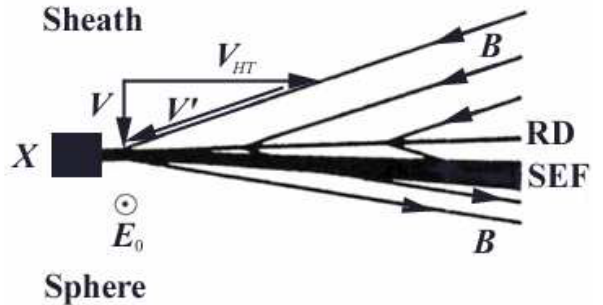
Fig. 1. Schematic drawing illustrating the difference between the deHoffmann-Teller (HT) frame and the proper frame (the frame of the drawing) for an asymmetric two-dimensional reconnection con- figuration at the magnetopause. This configuration (only half of which is shown) contains an upstream rotational discontinuity (RD) followed by a slow-mode expansion fan (SEF) (Levy et al., 1964). In the HT frame, which moves to the right with speed V HT rela- tive to the proper frame, the plasma flow, V 0 , crossing the RD is along the magnetic field so that the tangential electric field in the RD, including the component E z , vanishes at locations well away from the SEF and the reconnection site (the X-point). In the HT frame, the SEF structure appears to be moving downward, away from the RD, while the reconnection site is moving to the left: the global configuration is time dependent. In the proper frame, the en- tire reconnection configuration is time stationary and anchored to the X. The inflow velocity is V and the electric field component E z is nonzero and constant, E z = E 0 , within the entire configuration; E 0 is the reconnection electric field (from Sonnerup and Teh,